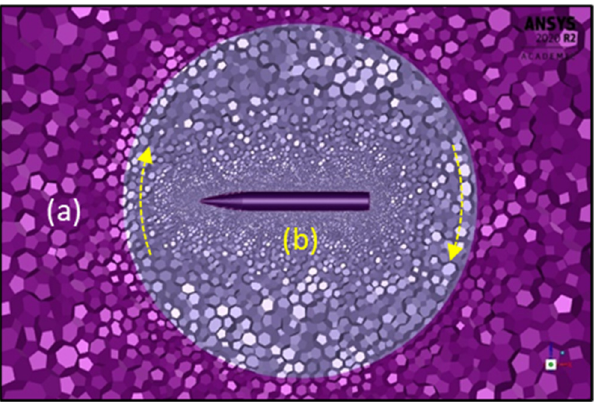
Figure 8. Dynamic mesh set ‐ up: ( a ) static zone (far field), ( b ) moving zone. To set up the dynamic meshing method, prescribed motion is set in UDF in Fluent [28]. There are six components in the UDF, three components of translational velocity and three of angular velocity. There are a total of three UDF for three simple harmonic oscillation modes. For the first UDF, the pitching motion of the model can made by giving the angular velocity with the sinusoidal motion along the y ‐ axis. For the second UDF, the plunging motion is made by providing the velocity in the translational direction along the z ‐ axis only. For the third UDF, the flapping motion is made by combining both input from the first and the second motion, providing the angular velocity along the y ‐ axis and trans ‐ lational velocity along the z ‐ axis. The summary of the UDF for each mode can be seen in